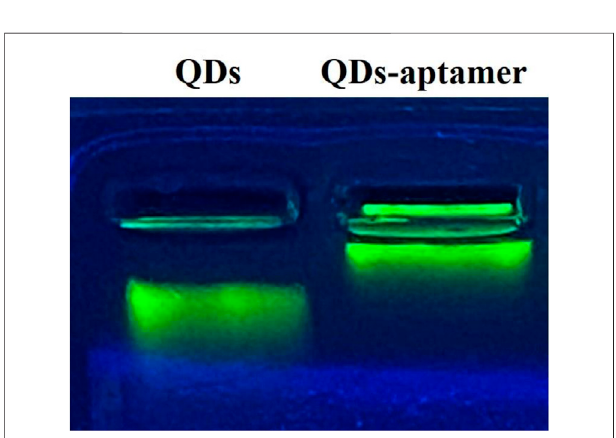
FIGURE 3 | The agarose gel electrophoresis of QDs and QD-aptamers showed that QDs without a conjugated aptamer ran faster in agarose